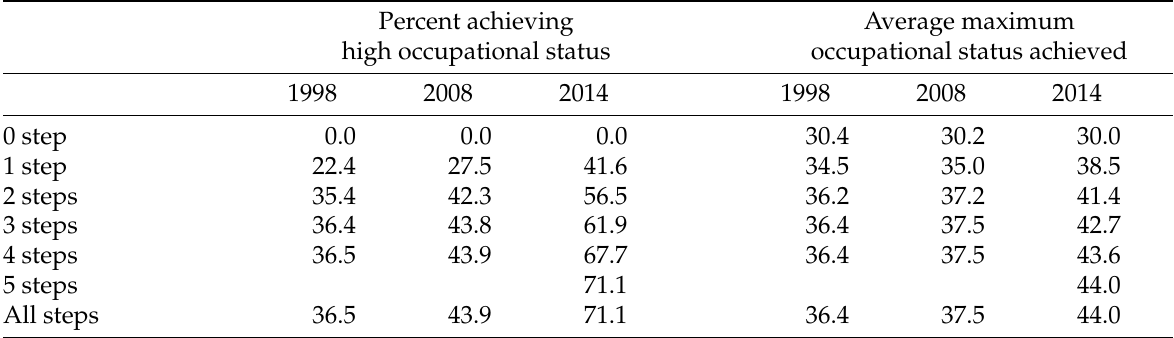
Table 4: Percent achieving high occupational status and average maximum occupational status achieved in successive number of steps by workers in low-status